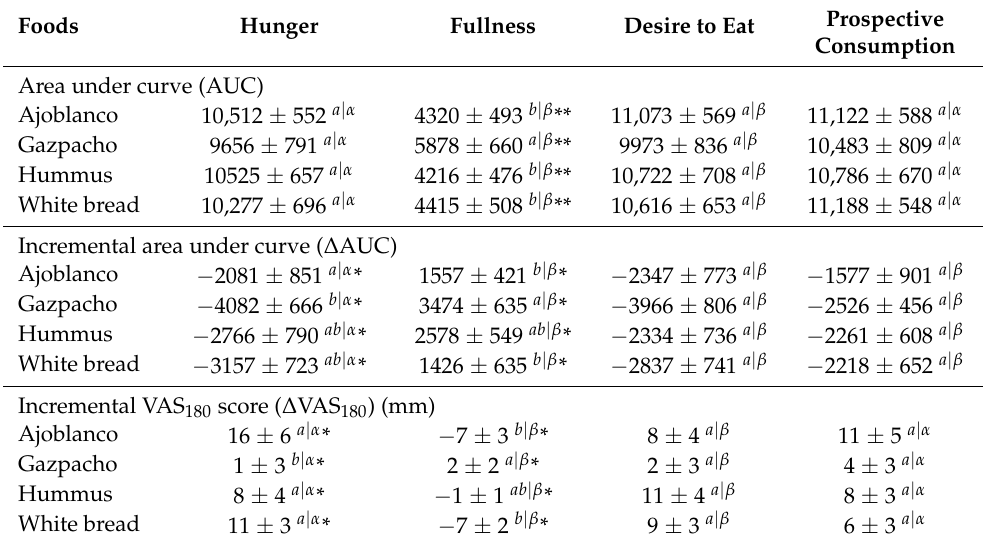
Table 2. Visual analogue scales (VAS) results expressed as AUC, ∆ AUC and ∆ VAS score at 180 min for each analysed